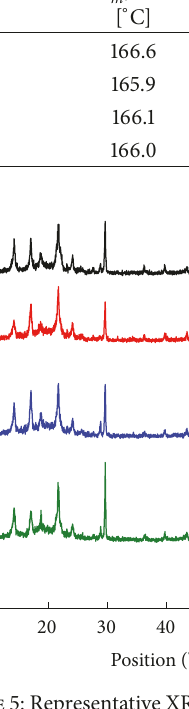
Table 5: Thermal parameters for RPP samples evaluated from DSC thermograms, first heating scan. Sample code